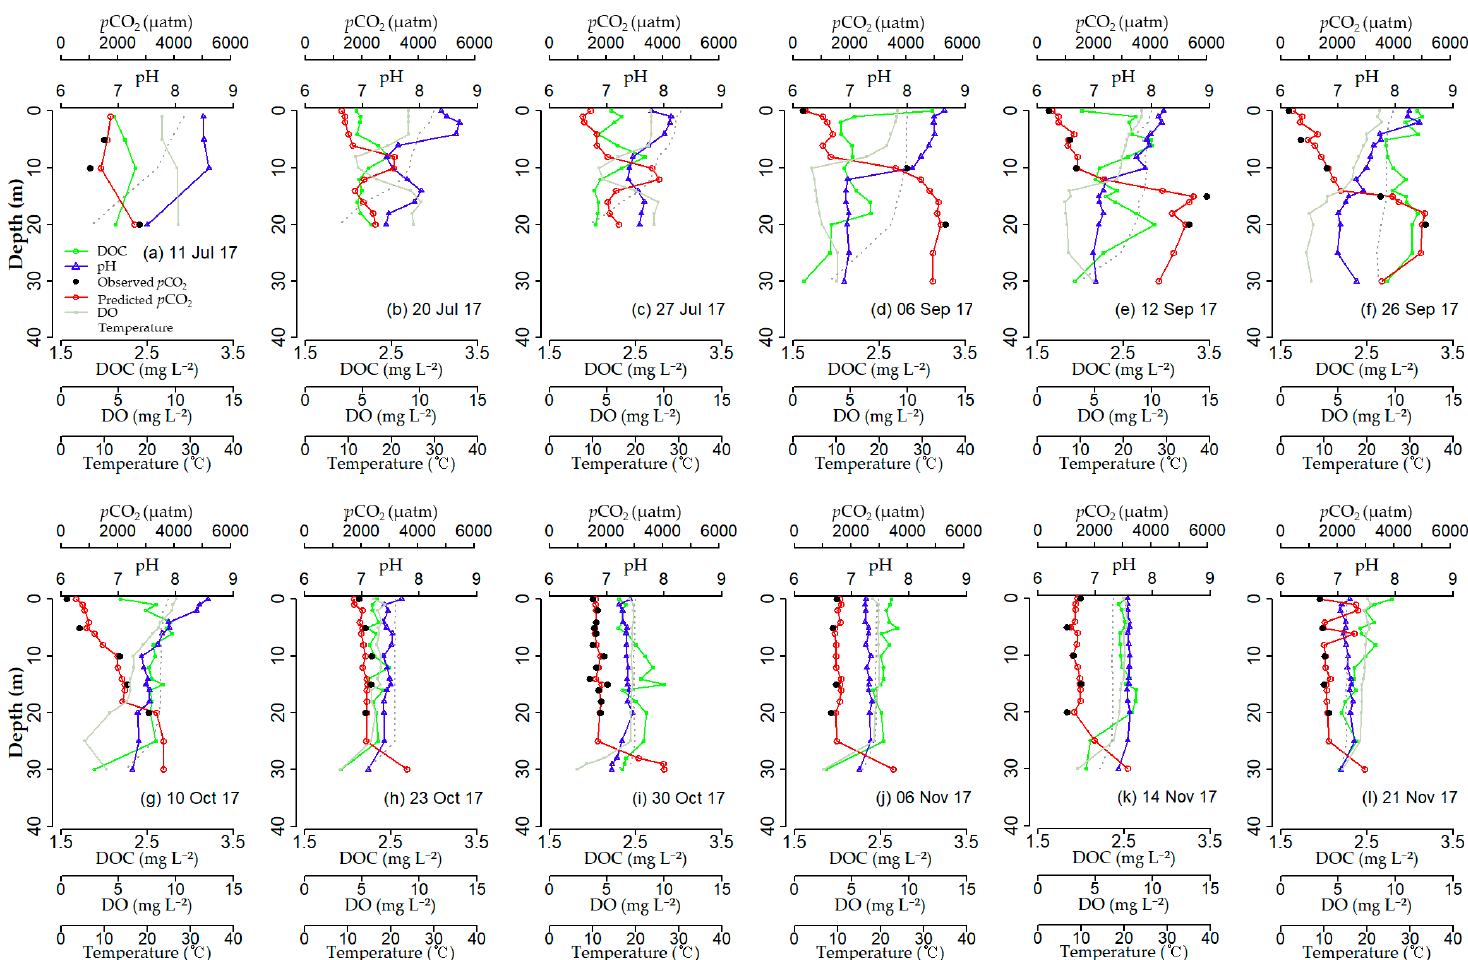
Figure 7. Dynamic vertical distributions of water temperature ( T w), pH, dissolved organic carbon (DOC), dissolved oxygen (DO), and p CO 2 . The observed p CO 2 values were measured in situ using the NDIR method.